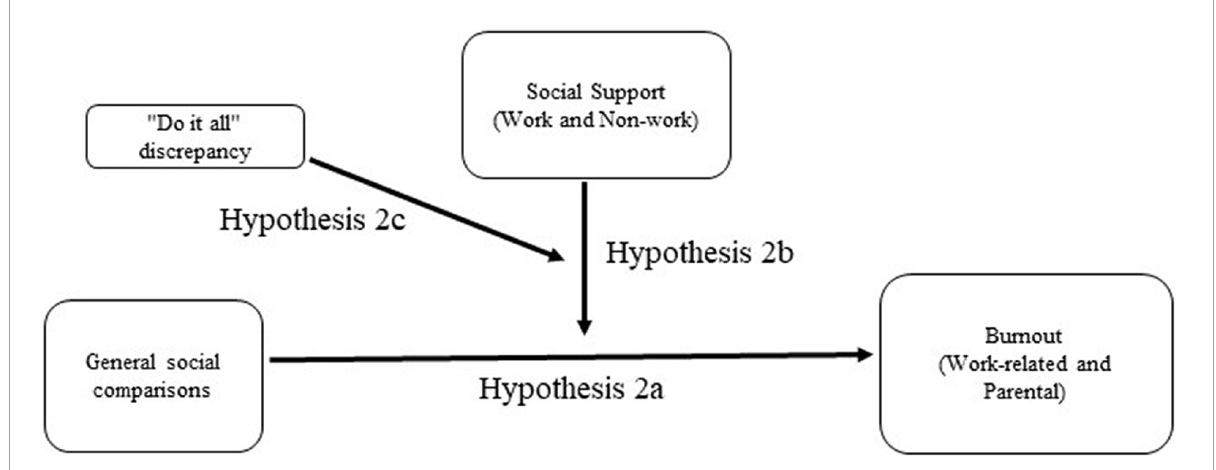
FIGURE1 Depiction of Hypothesis 1, where social media relates to work-related and parental burnout via emotions, moderated by social support.